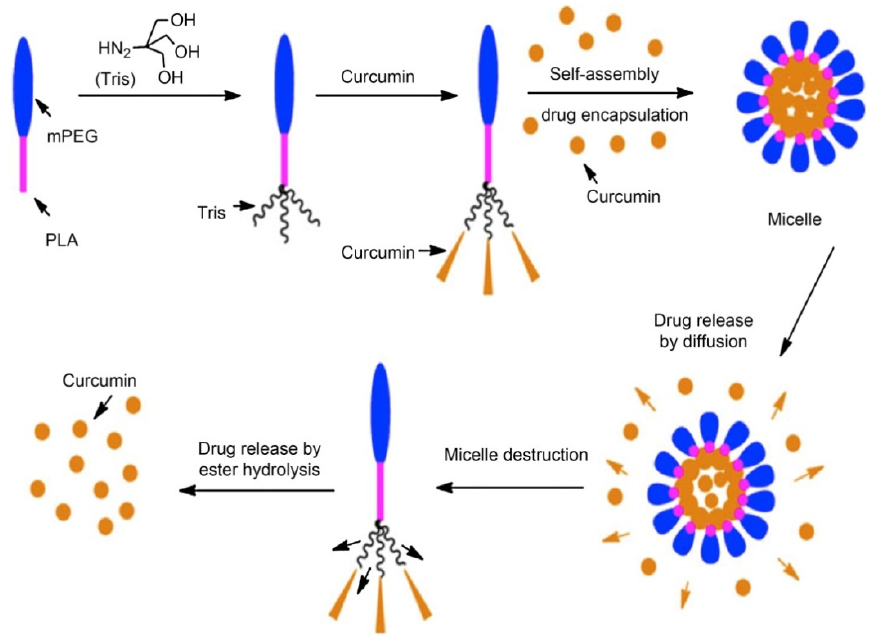
Figure 5. Methoxy-PEG–PLA–Tris–CUR nanoDDs: synthesis and loading with a consequent release of CUR. Reproduced from [156], Elsevier, 2014.